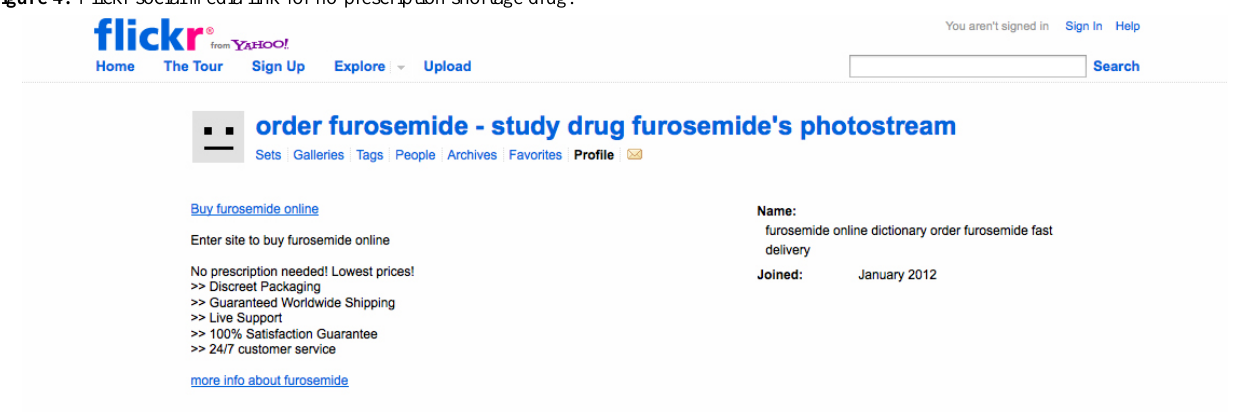
Figure 4. Flickr social media link for no-prescription shortage